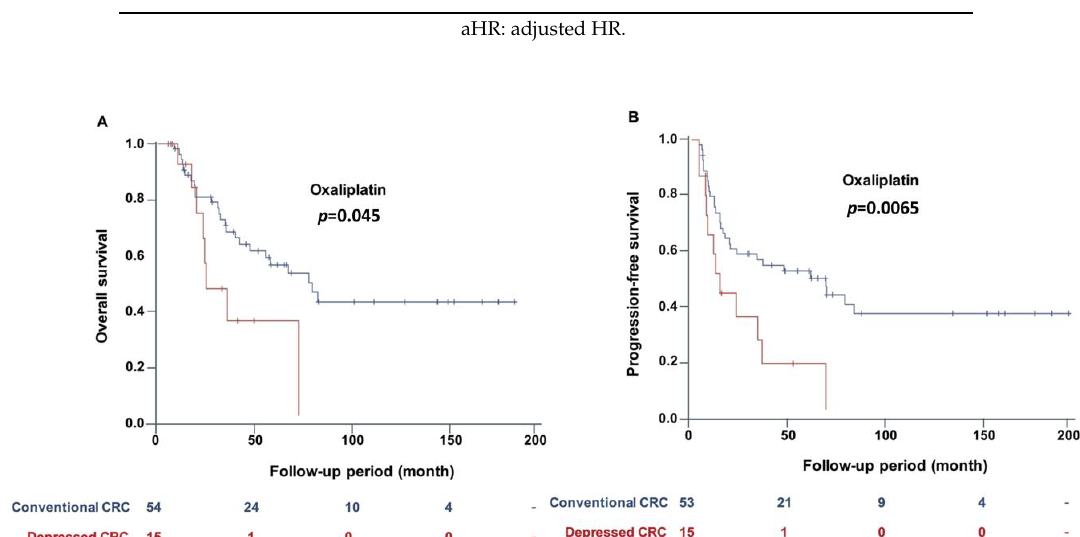
Figure 4. Comparison of survival outcome between proximal CRC with and without a positive D-marker panel when using oxaliplatin as first-line chemotherapy. Proximal CRC with a positive D-marker panel had a worse response to chemotherapy with oxaliplatin as a first-line agent. Compared to those without D-marker, proximal CRC with a positive D-marker panel had an unfavorable overall survival ( A ) and progression-free survival ( B ). The p -values were 0.045 and 0.0065, respectively.